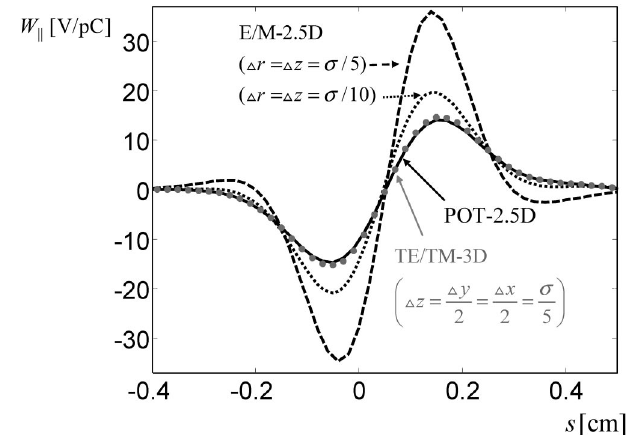
FIG. 9. Comparison of the wake potentials obtained by differ- ent methods for the structure consisting of 20 TESLA cells excited by a Gaussian bunch with 9 (cid:5) 1 mm . The solid line shows the reference solution obtained with the help of the scheme described in [13]. The dashed line describes the solution obtained by classical Yee’s scheme with mesh resolution of 5 mesh steps per 9 . The dotted line describes the solution obtained by Yee’s scheme with 2 times denser resolution in the longitu- dinal direction. The picture shows coincidence of the reference result (solid line) with the results on the coarse mesh obtained from the 3D TE/TM code (gray points).